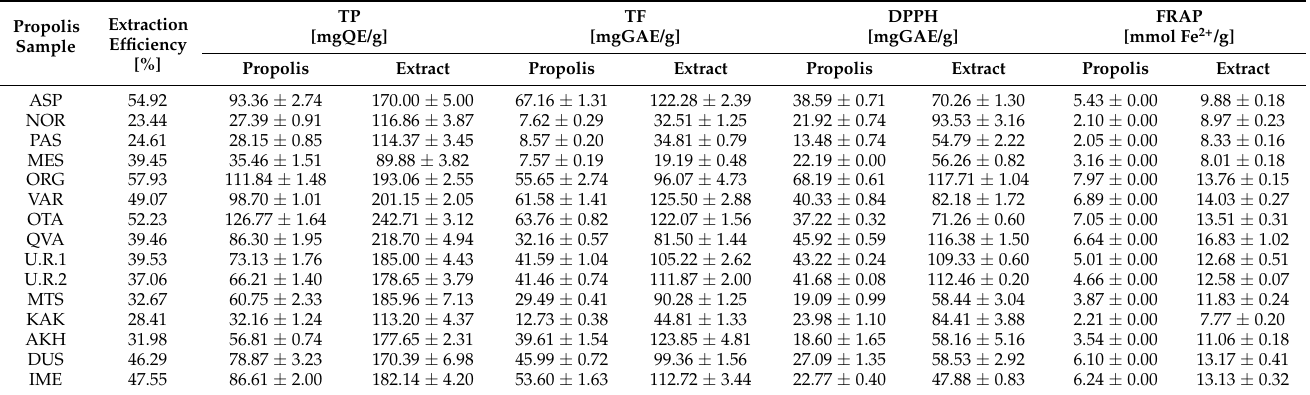
Table legend: ASP—Aspindza; NOR—Norio; PAS—Pasanauri; MES—Mestia; ORG—Orgora; VAR—Vardzia; OTA—Ota; QVA—Qvakhreli U.R.1—unknown region 1; U.R.2—unknown region 2;